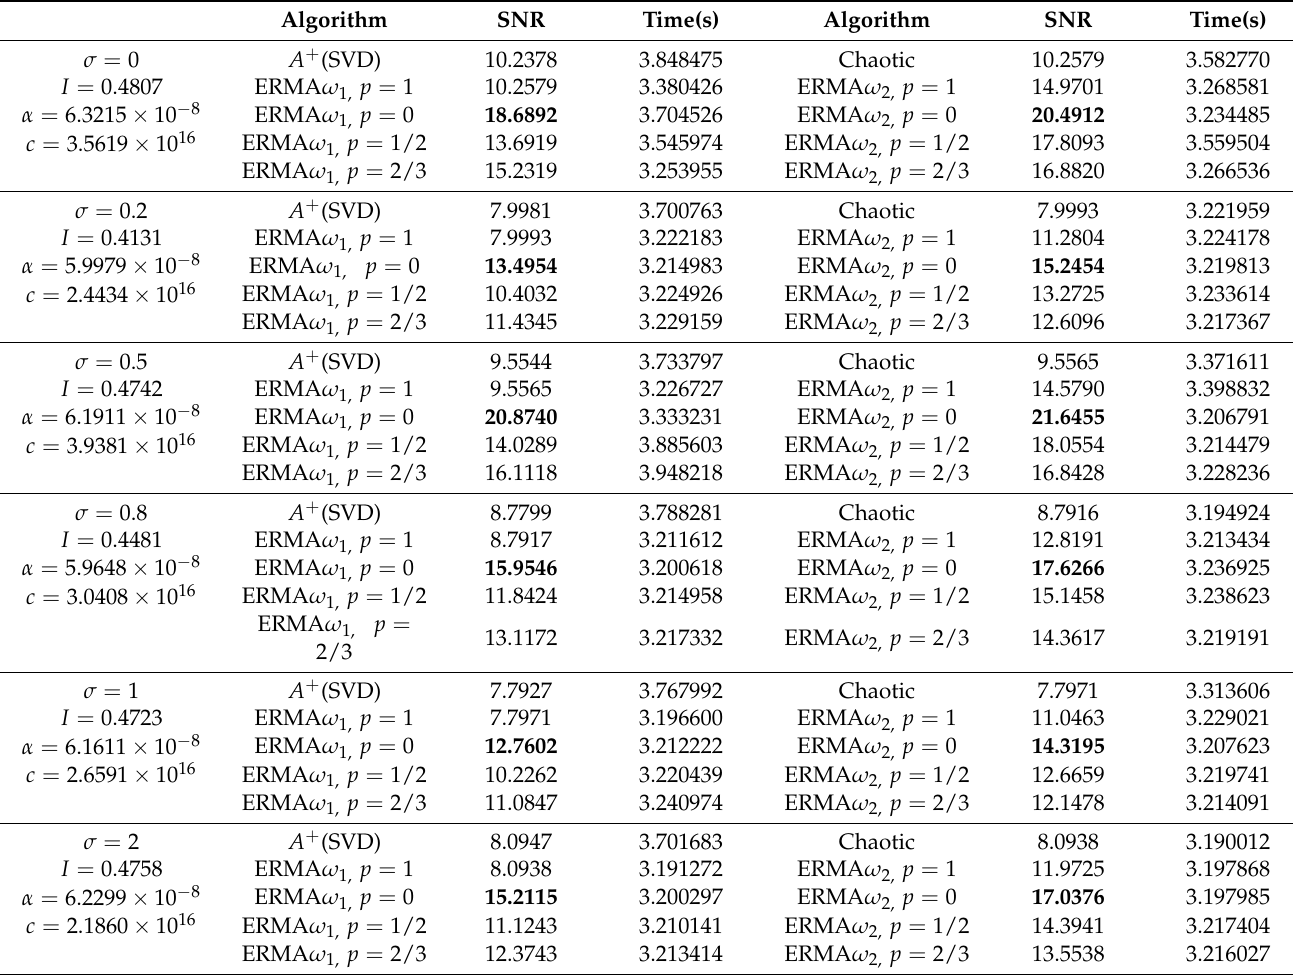
Table 2. The comparison of ( m , n , rank ( A ) , n NZ ) = (1000, 5000, 500,